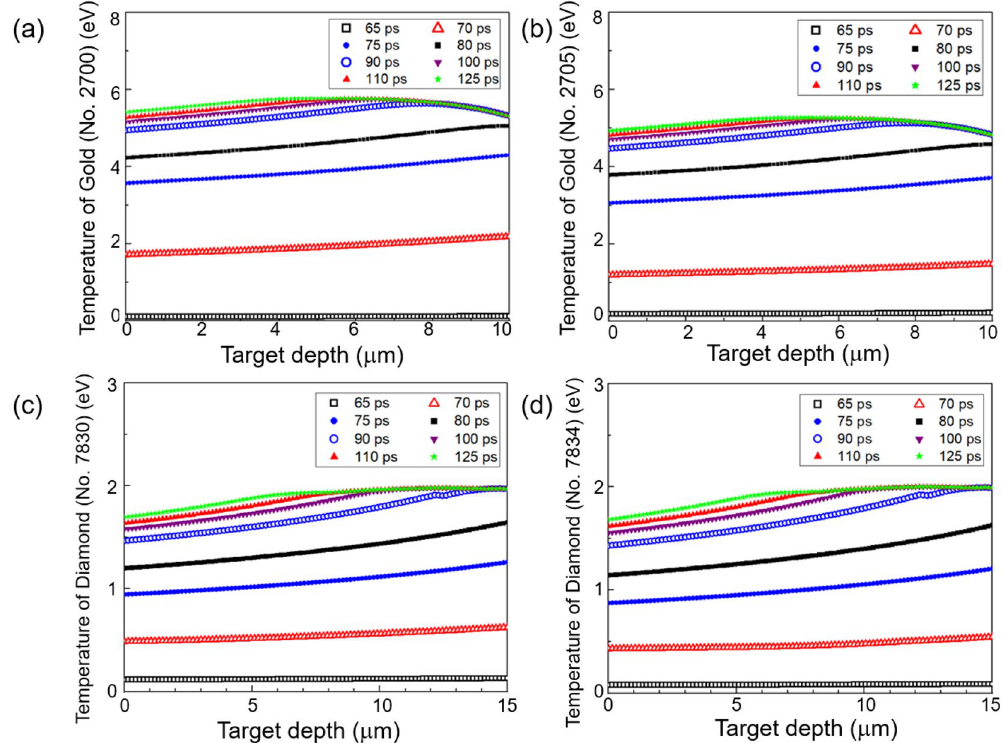
Figure 4. The temperature distribution within the 10-μm-thick gold sample is shown at different times from 65 to 125 ps. The temperatures are calculated using the SESAME EOS Tables ( a ) No. 2700 and ( b ) No. 2705. Similarly, the temperature distribution within the 15-μm-thick diamond is shown at different times using the SESAME EOS Tables ( c ) No. 7830 and (d) No.